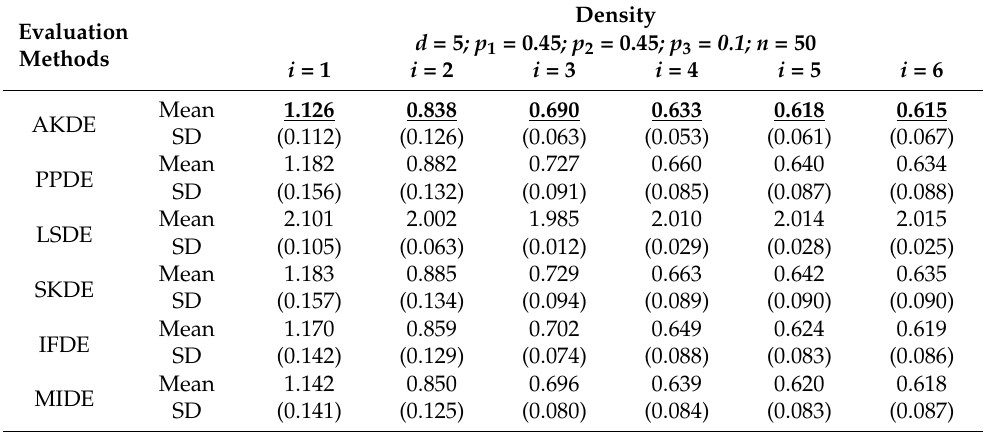
Table A10. 10 4 times upscaled mean absolute error with d = 5 ; p 1 = 0.45 ; p 2 = 0.45 ; p 3 = 0.1 ; n =